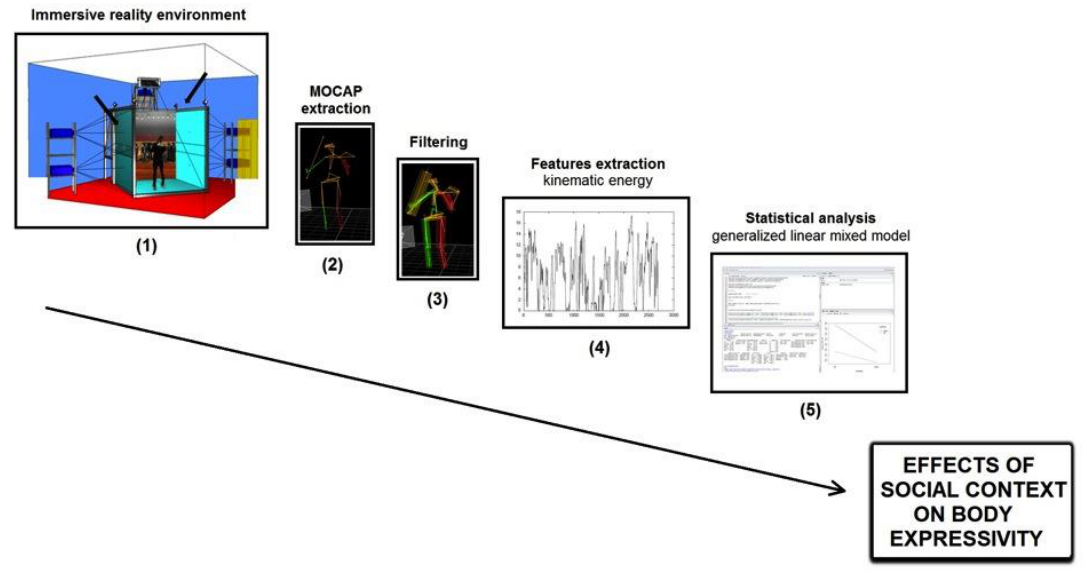
Figure 1 . Visualization of the data processing and analysis steps in evaluation of the difference in musician's behavioral response according to the expressive conditions (metronomic, concert-like and emphatic) and social contexts (absent, disengaged and engaged